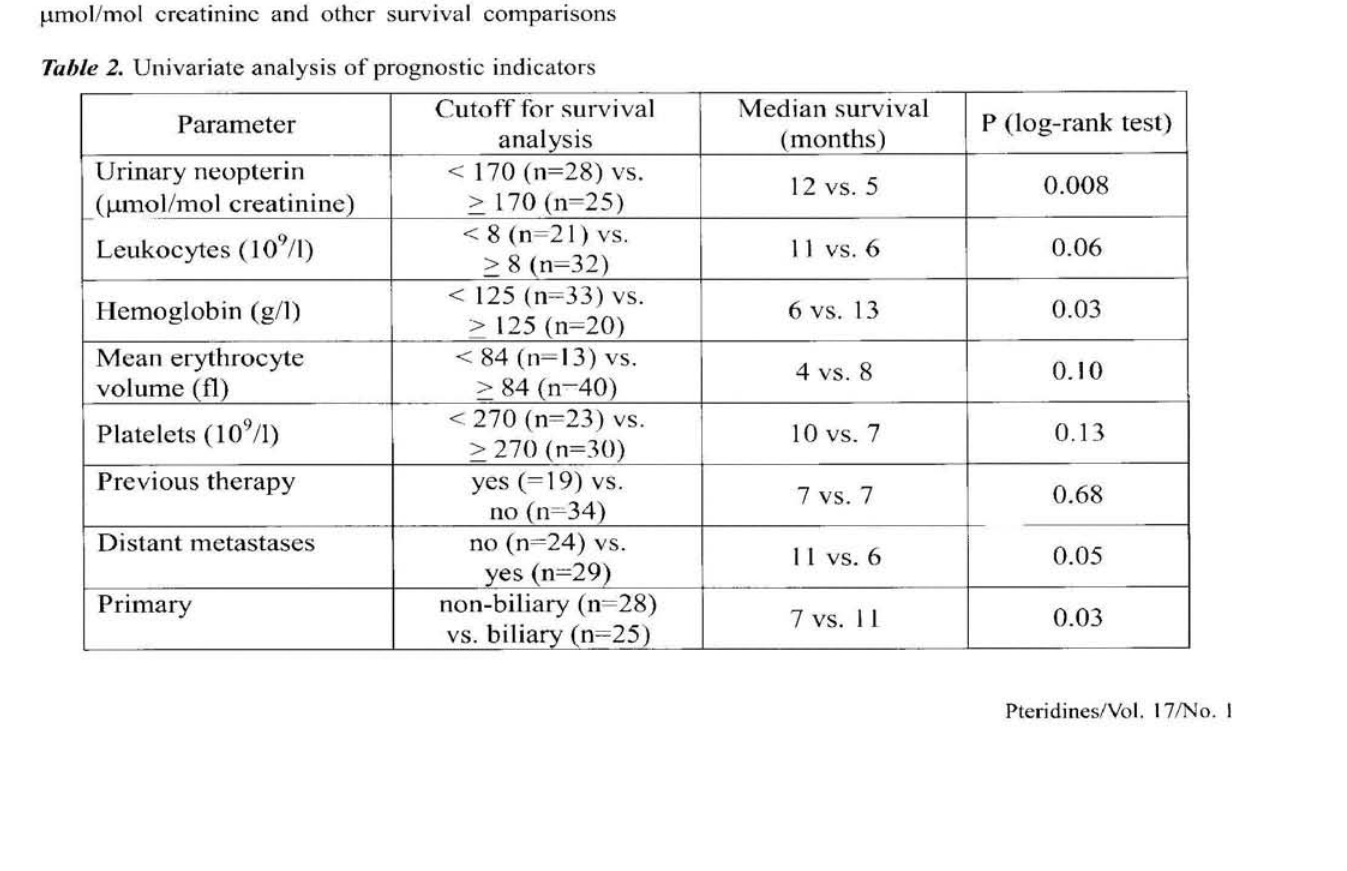
Median survival